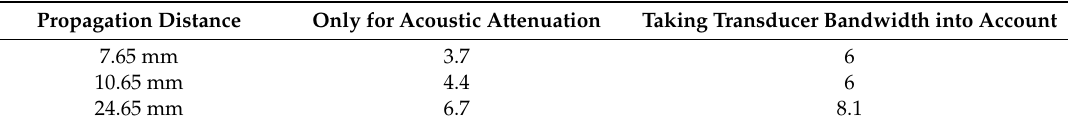
Table 2. Spatial resolution δ resolution in µ